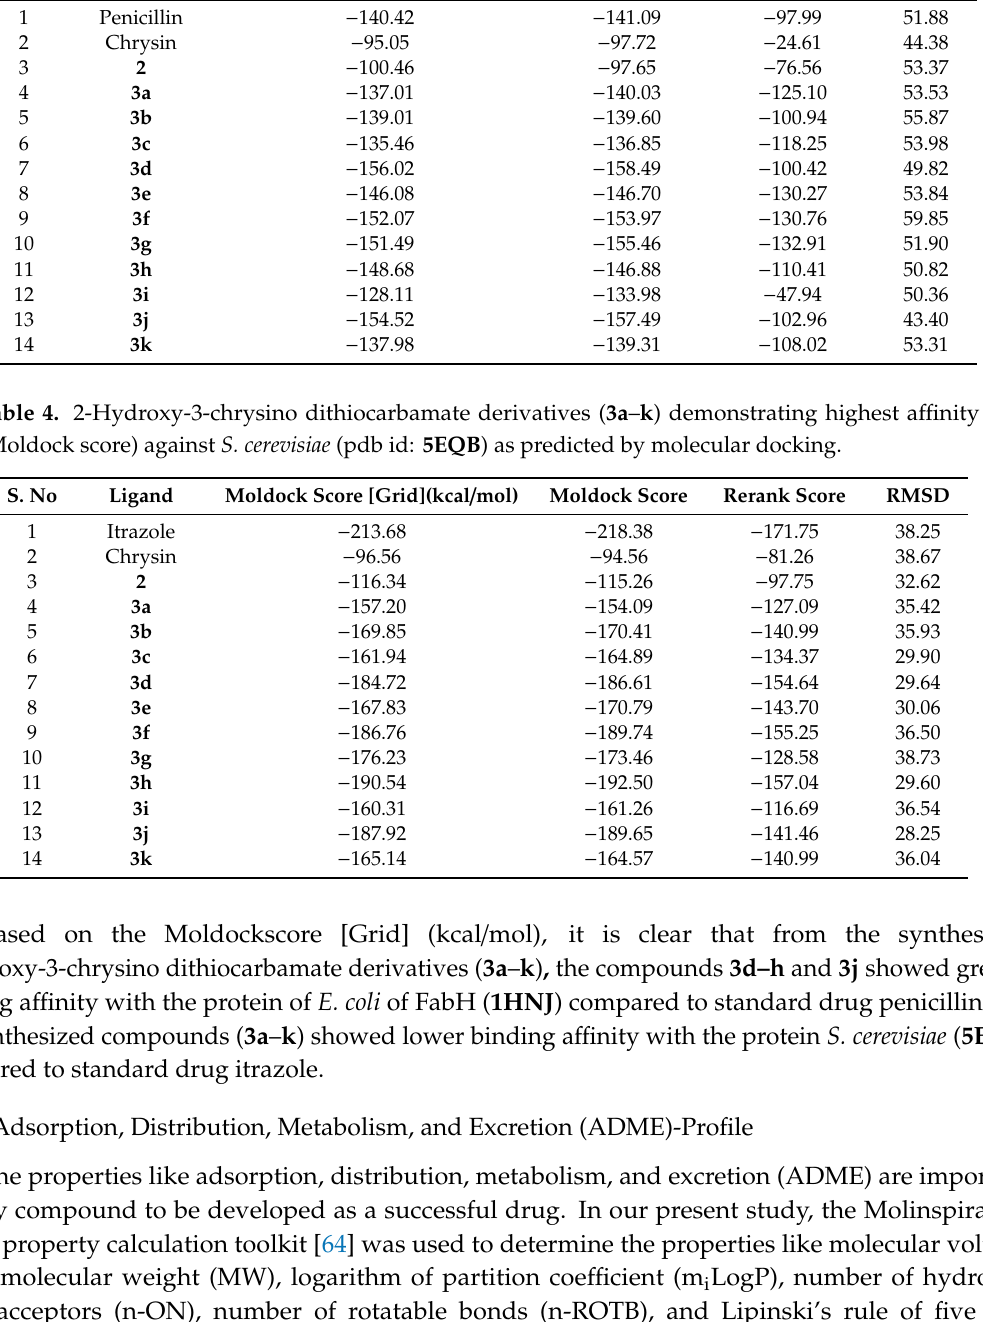
Drug-likeness model score is computed by using the Molsoft software [67], which is a collective property of physico-chemical properties, pharmacokinetics and pharmacodynamics. The pharmacokinetic parameters were calculated for the known inhibitors, synthesized analogues ( 3a – k ), and the standard drugs, shown in Table